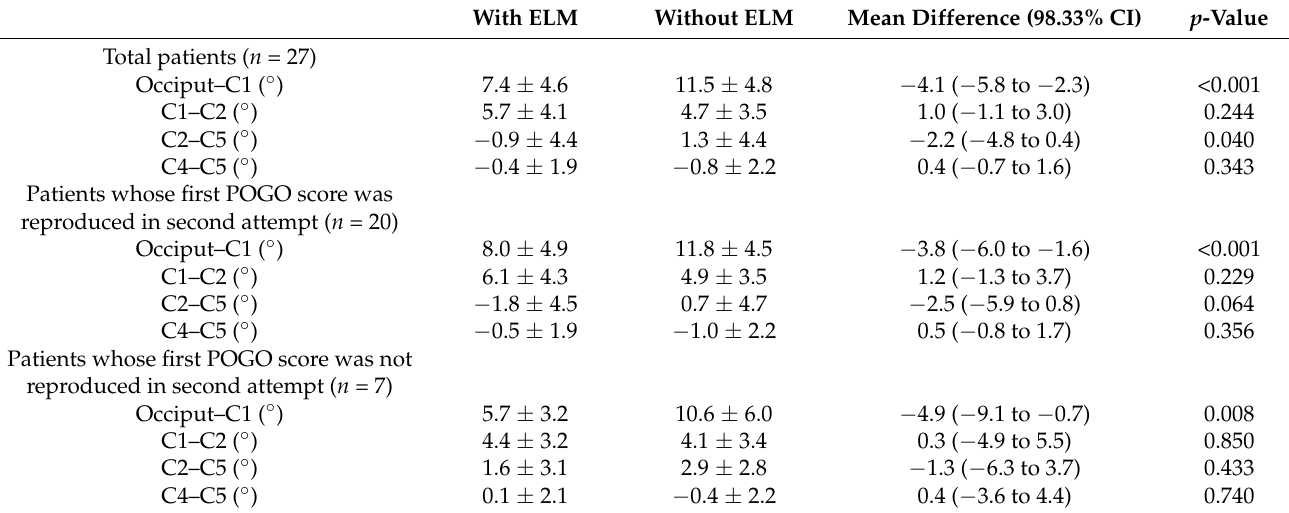
Table 2. Cervical spine motion during intubation.